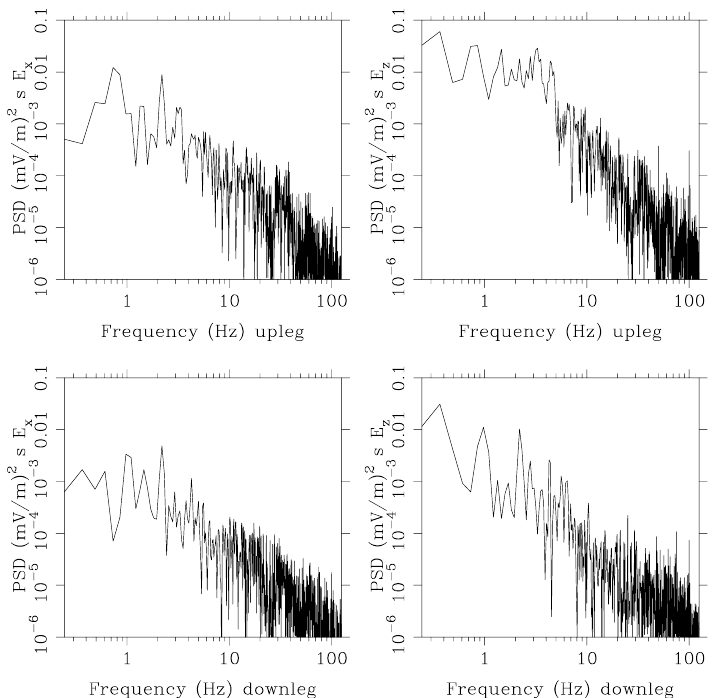
Fig. 8. Power spectra of the bottom-type layer electric fields measured on 7 August 2004. A frequency of 1Hz corresponds roughly to a wavelength of 1.8km.